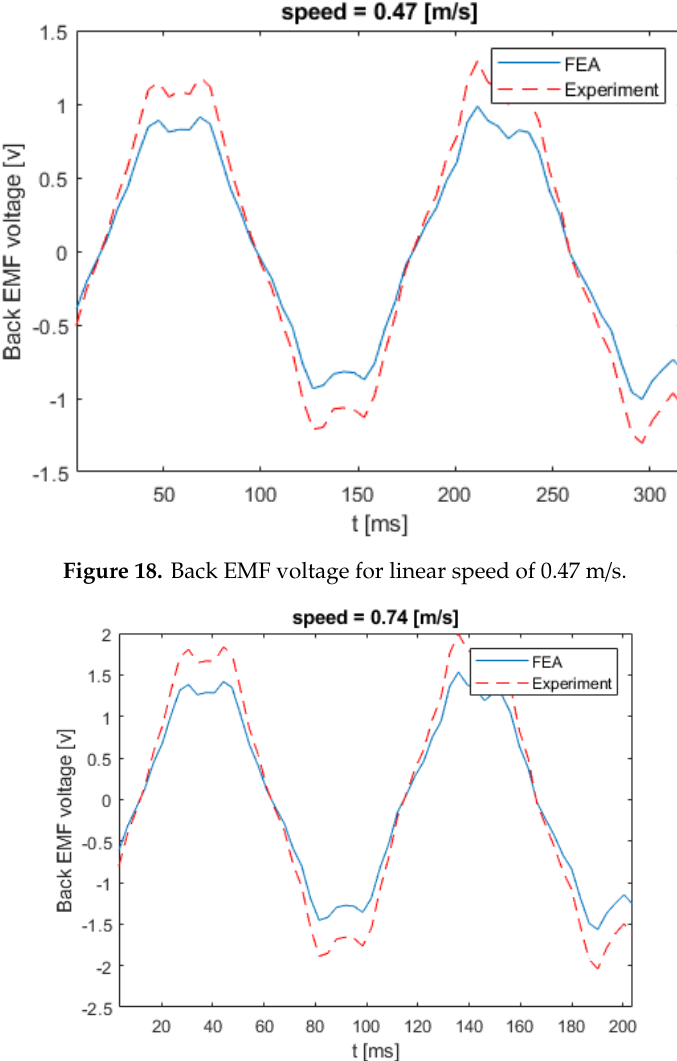
Figure 20. Back EMF voltage for linear speed of 1 m/s. 6. Conclusions Wave energy is one of the potential resources containing a high energy density per volume of water. Although there are many methods available to harness electrical energy from waves, none of them have succeeded in harnessing the full potential. Many of those methods have complex designs, poor efficiency, are extremely expensive, and require thorough maintenance. These factors hinder the feasibility of wave-energy-based power production. The huge number of intricate moving parts in traditional wave energy converters, such as turbines and gear boxes, reduces the efficiency of the system. In this paper, a novel rolling electrical generator for wave power generation is proposed and designed, with the objective of providing a simplified design, minimal maintenance, and optimal efficiency of the overall system. This design makes use of the sinusoidal motion of a wave (prime mover) to generate electrical power. The proposed design cuts down the levels of power conversion by one order to improve the overall efficiency. The design is validated by both the simulation and experimental results as a proof of concept. The approximate cost estimated to install the proposed design at a capacity of 1500 MW in costal India at a 10% rate of each machine is around $400 million USD.